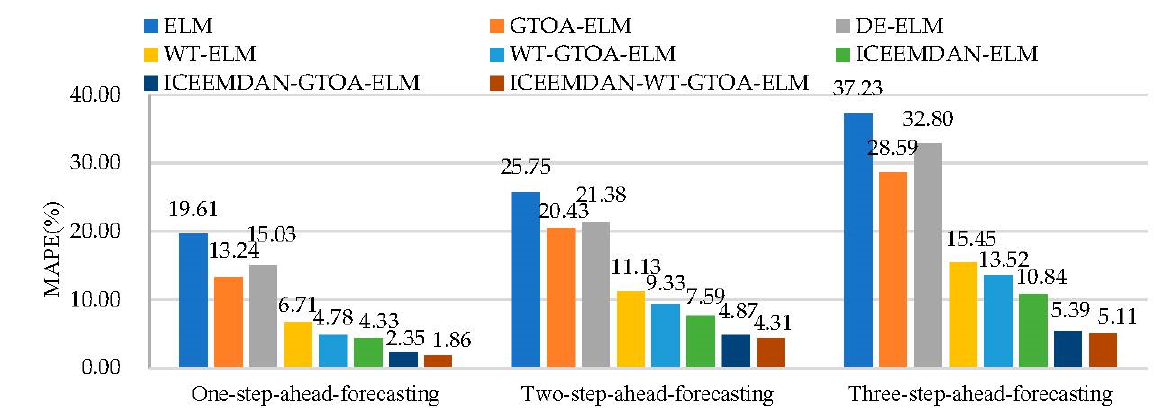
Figure 9. MAE of PM2.5 forecasting.